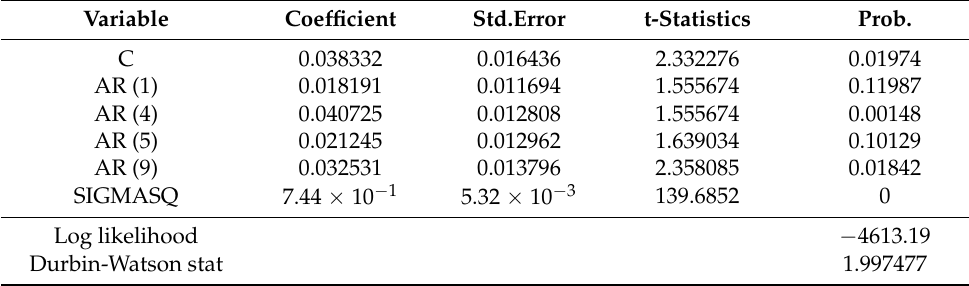
Table 4. Results of Least Squares and ARMA